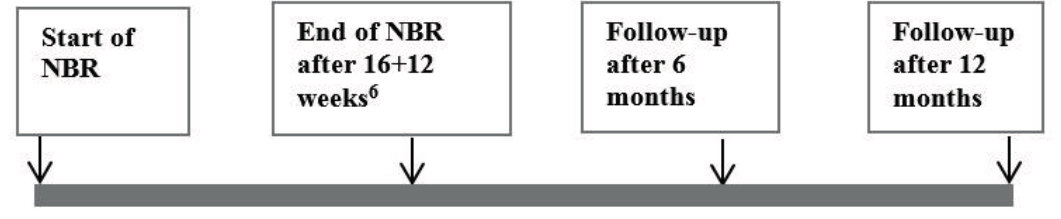
Figure 3. Time frame for the collection of data by self-assessment instruments from the participants in the Nature Based Rehabilitation. Note 6 : 16 weeks of rehabilitation followed by 12 weeks of gradual return to work or